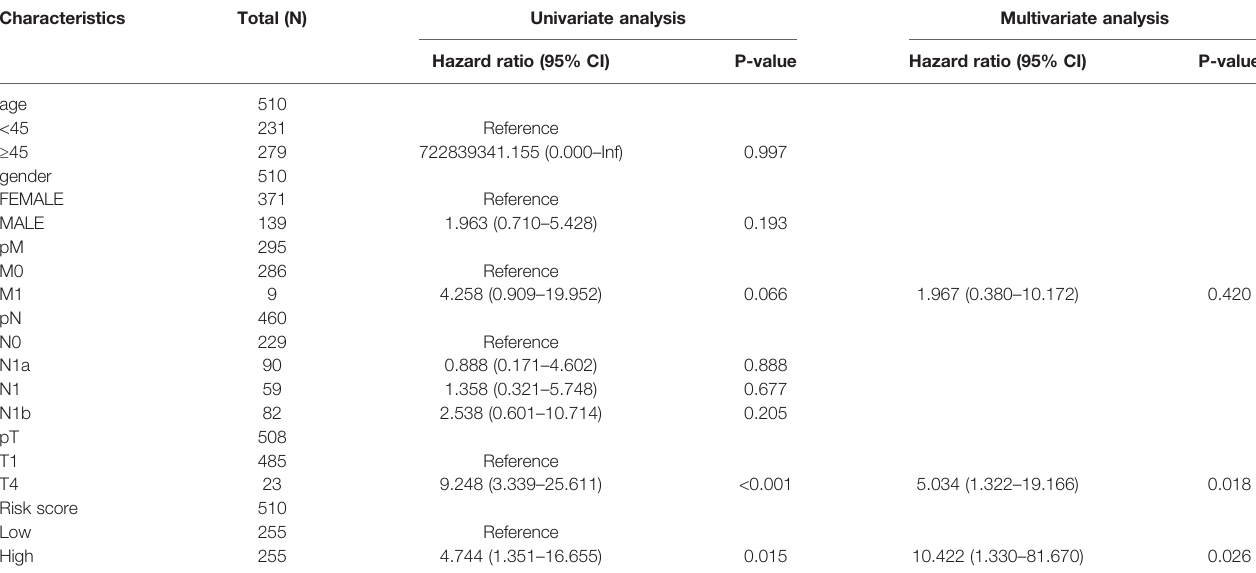
TABLE 1 | Univariate and multivariate Cox regression analysis of clinical information and risk score.